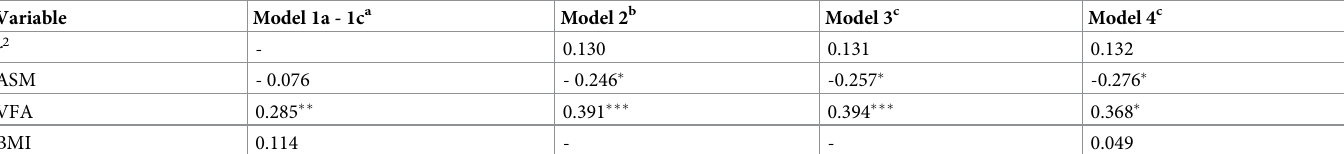
ASM, appendicular skeletal muscle; BMI, body mass index; VFA, visceral fat area. Parameter estimates are presented in the form of standardized coefficients. a Bivariate relationships between individual predictors and risk factors. b Multiple regression with no control covariates. c Includes control covariate adjusting for